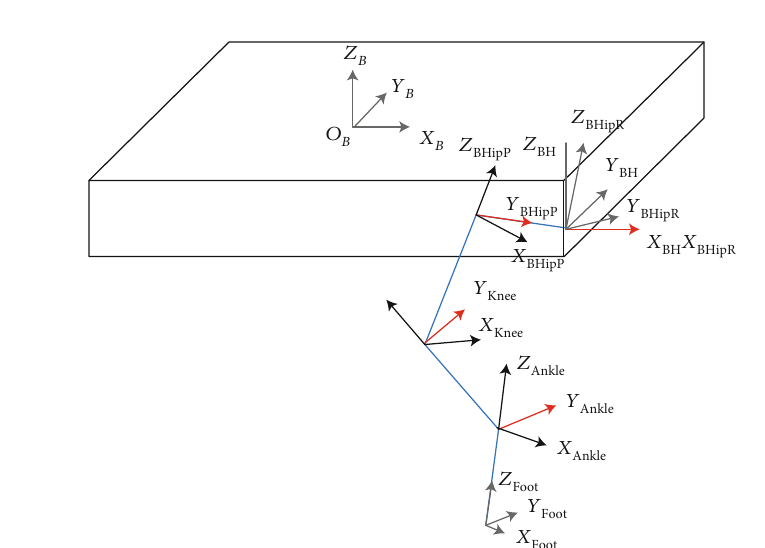
Figure 1: Overall of the control diagram.